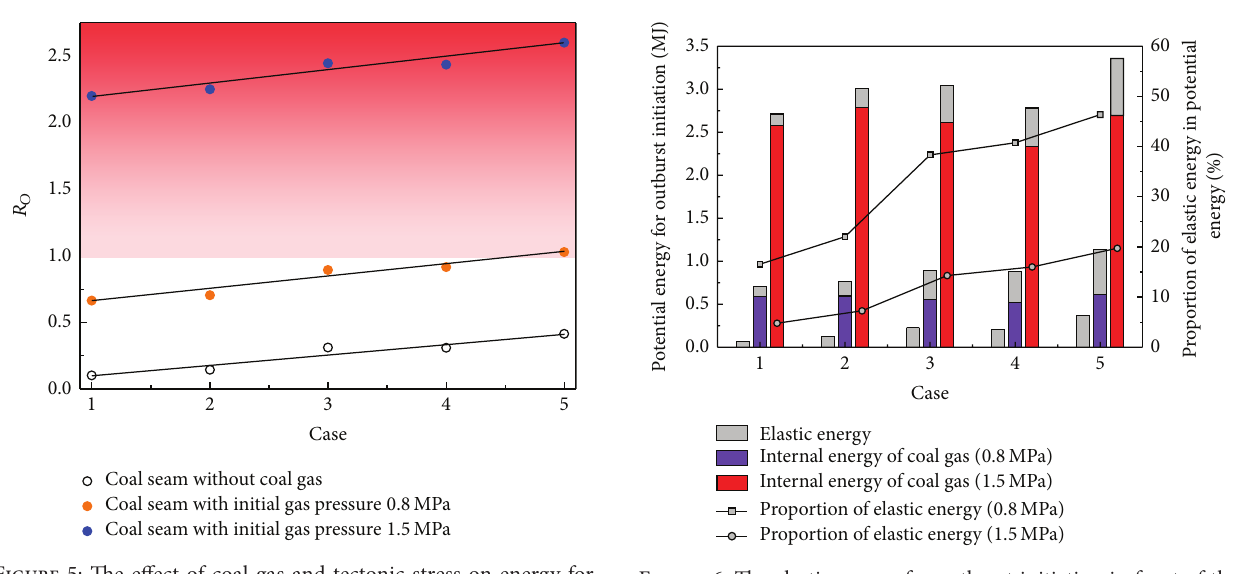
Figure 6: The elastic energy for outburst initiation in front of the